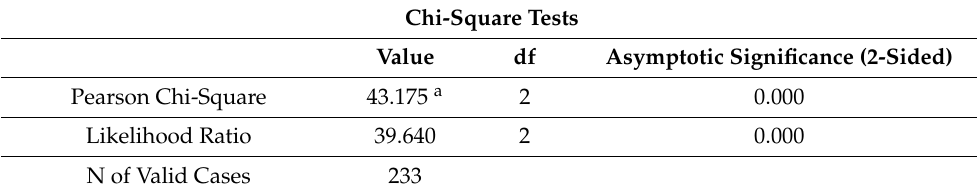
Table 6. Chi-Square Tests of (Q11) and